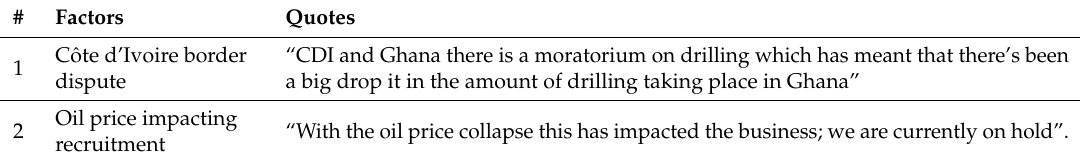
Table 15. ‘External international activities’ theme.